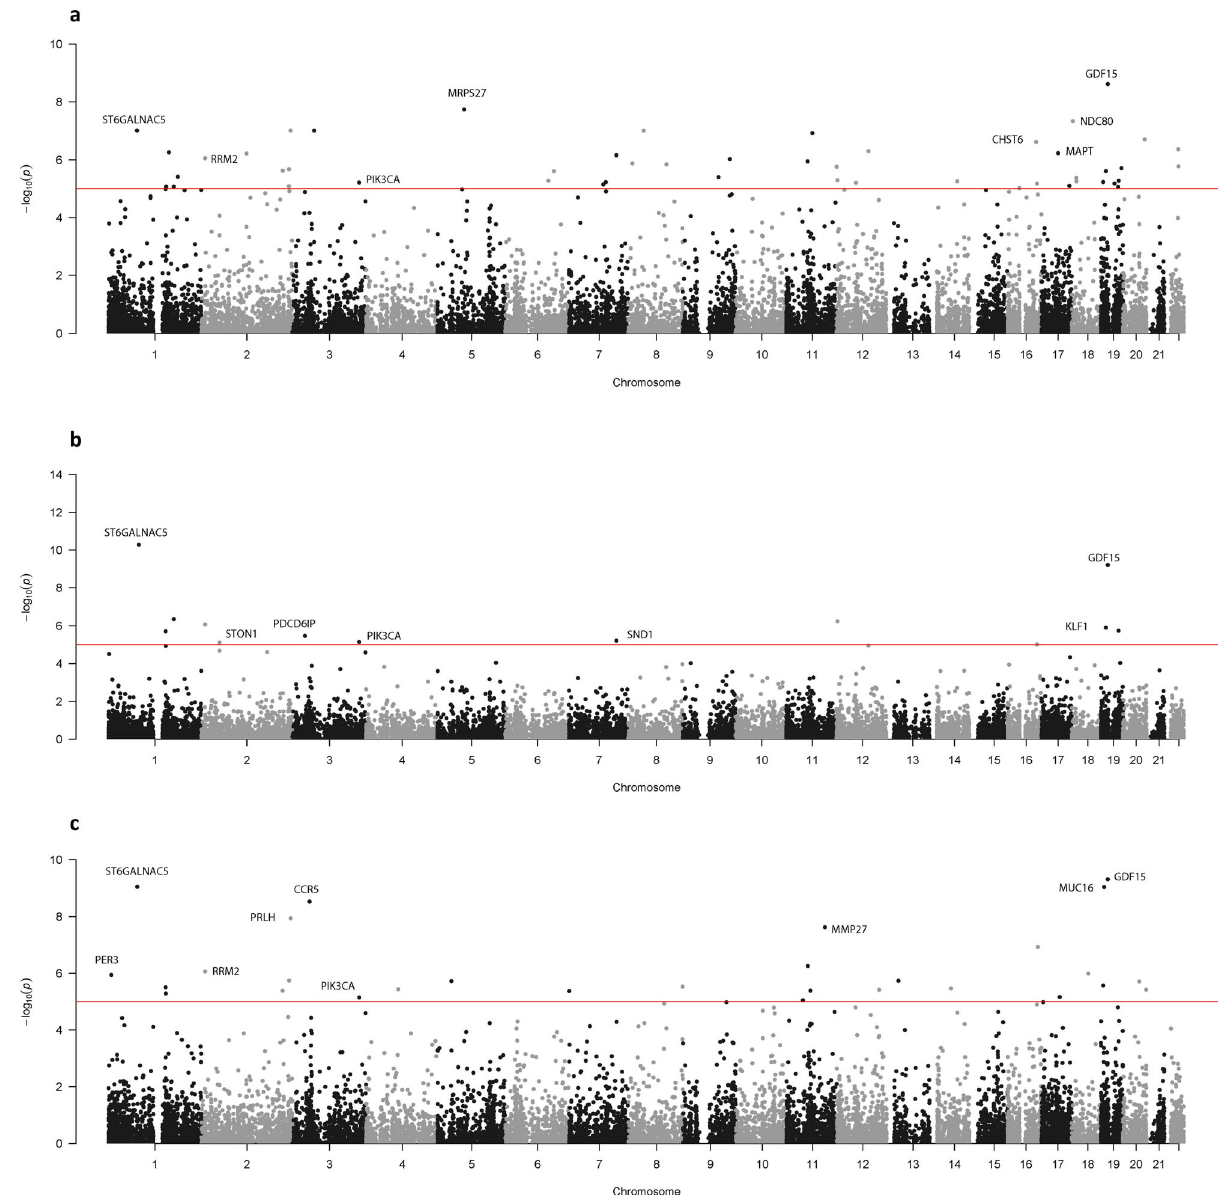
Fig. 3 P -values of the Indo-European meta-analysis. The gene-based p -values of the meta-analysis association study ( N = 22,139) combining the four Indo-European derived cohorts using the ( a ) EMMAX-VT test, ( b ) EMMAX-CMC test, and ( c ) ACAT. The line represents the genome-wide signi fi cant threshold of 1 ×10 − 5 . These plots are based on results in Supplementary Data 15 – 17,